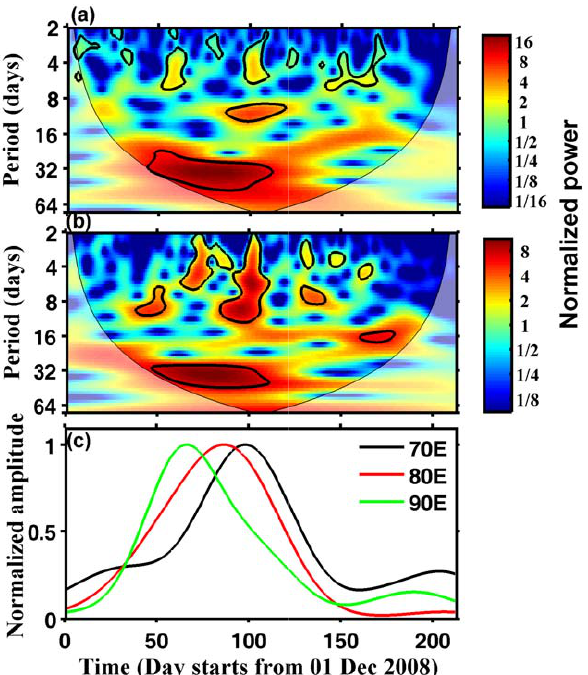
Fig. 3. Wavelet spectra applied for (a) zonal and (b) meridional wind components of NCEP/NCAR as a function of day number (starting from 1 December 2008) at 600hPa. (c) Normalised ampli- tude of filtered 25–45 day oscillations for three longitudes, 70, 80 and 90 ◦ E, during the observational period. Contours in the wavelet spectra represent 90% confidence